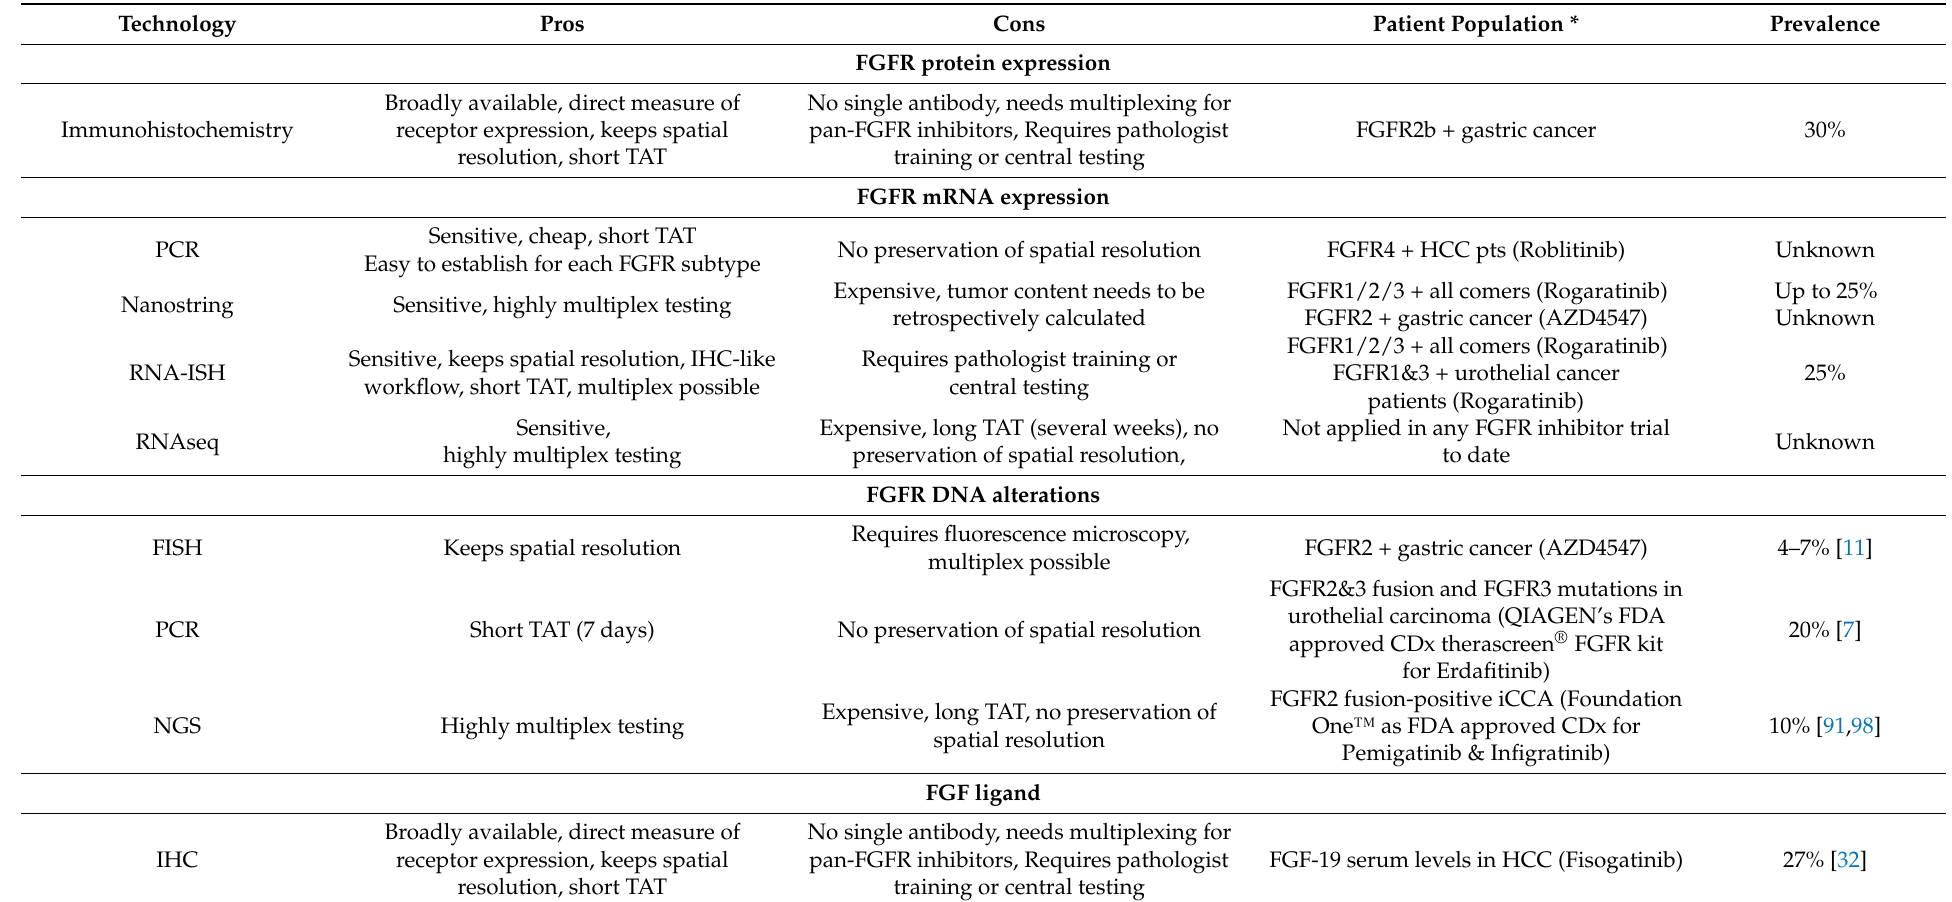
Table 2. Methods used in clinical trials to identify patients for FGFR inhibitor